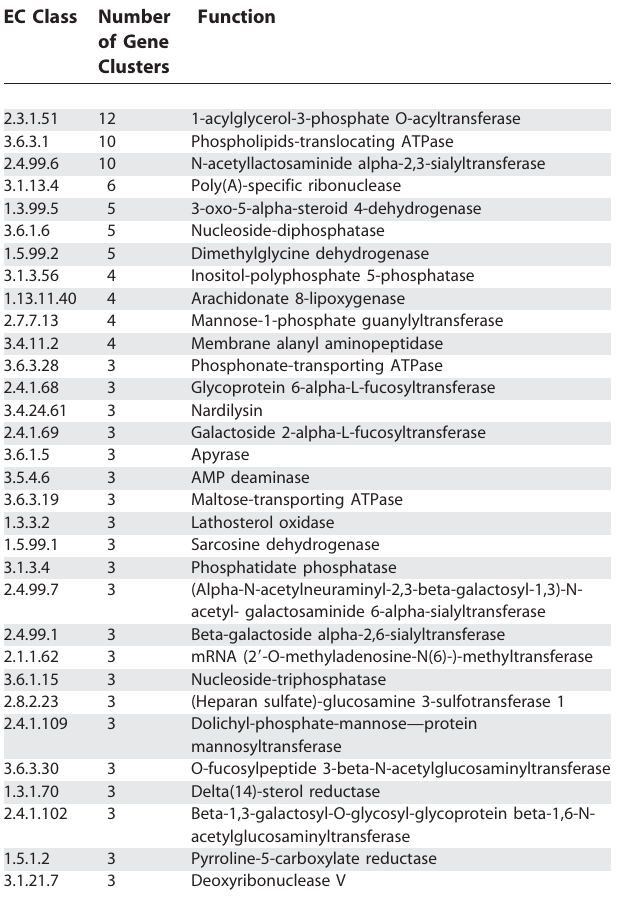
EC Class Number of Gene Clusters